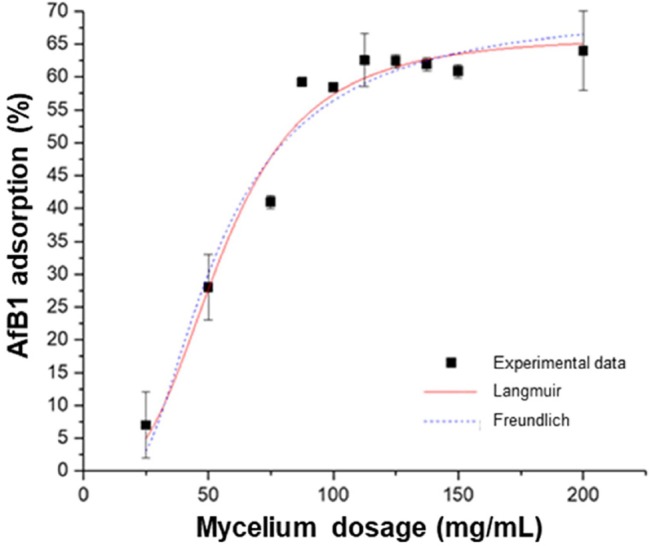
Effect of adsorbent dosage on AfB1 adsorption by mycelium. Equilibrium adsorption isotherms were obtained at constant temperature (37°C) and pH (7) by testing a fixed amount of mycotoxin with increasing adsorbent dosage.